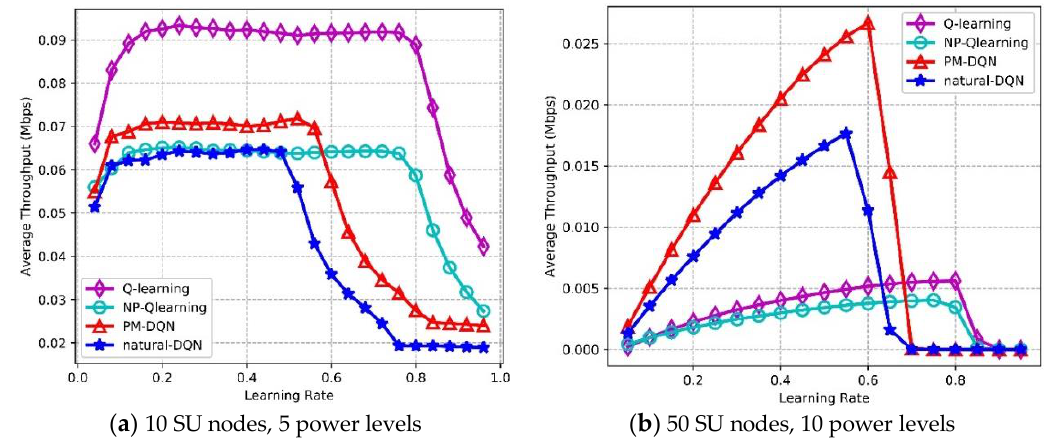
Figure 14. Average throughput vs. learning rate.